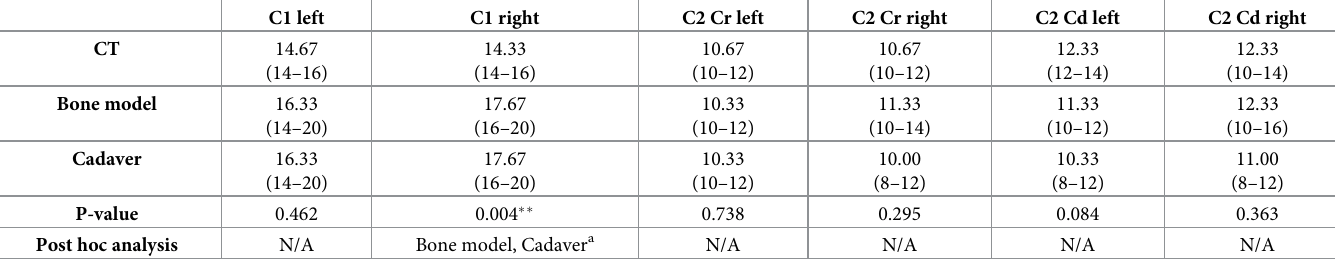
Table 4. Screw length in millimeters determined using CT, bone models, and cadavers in the guide group. C1